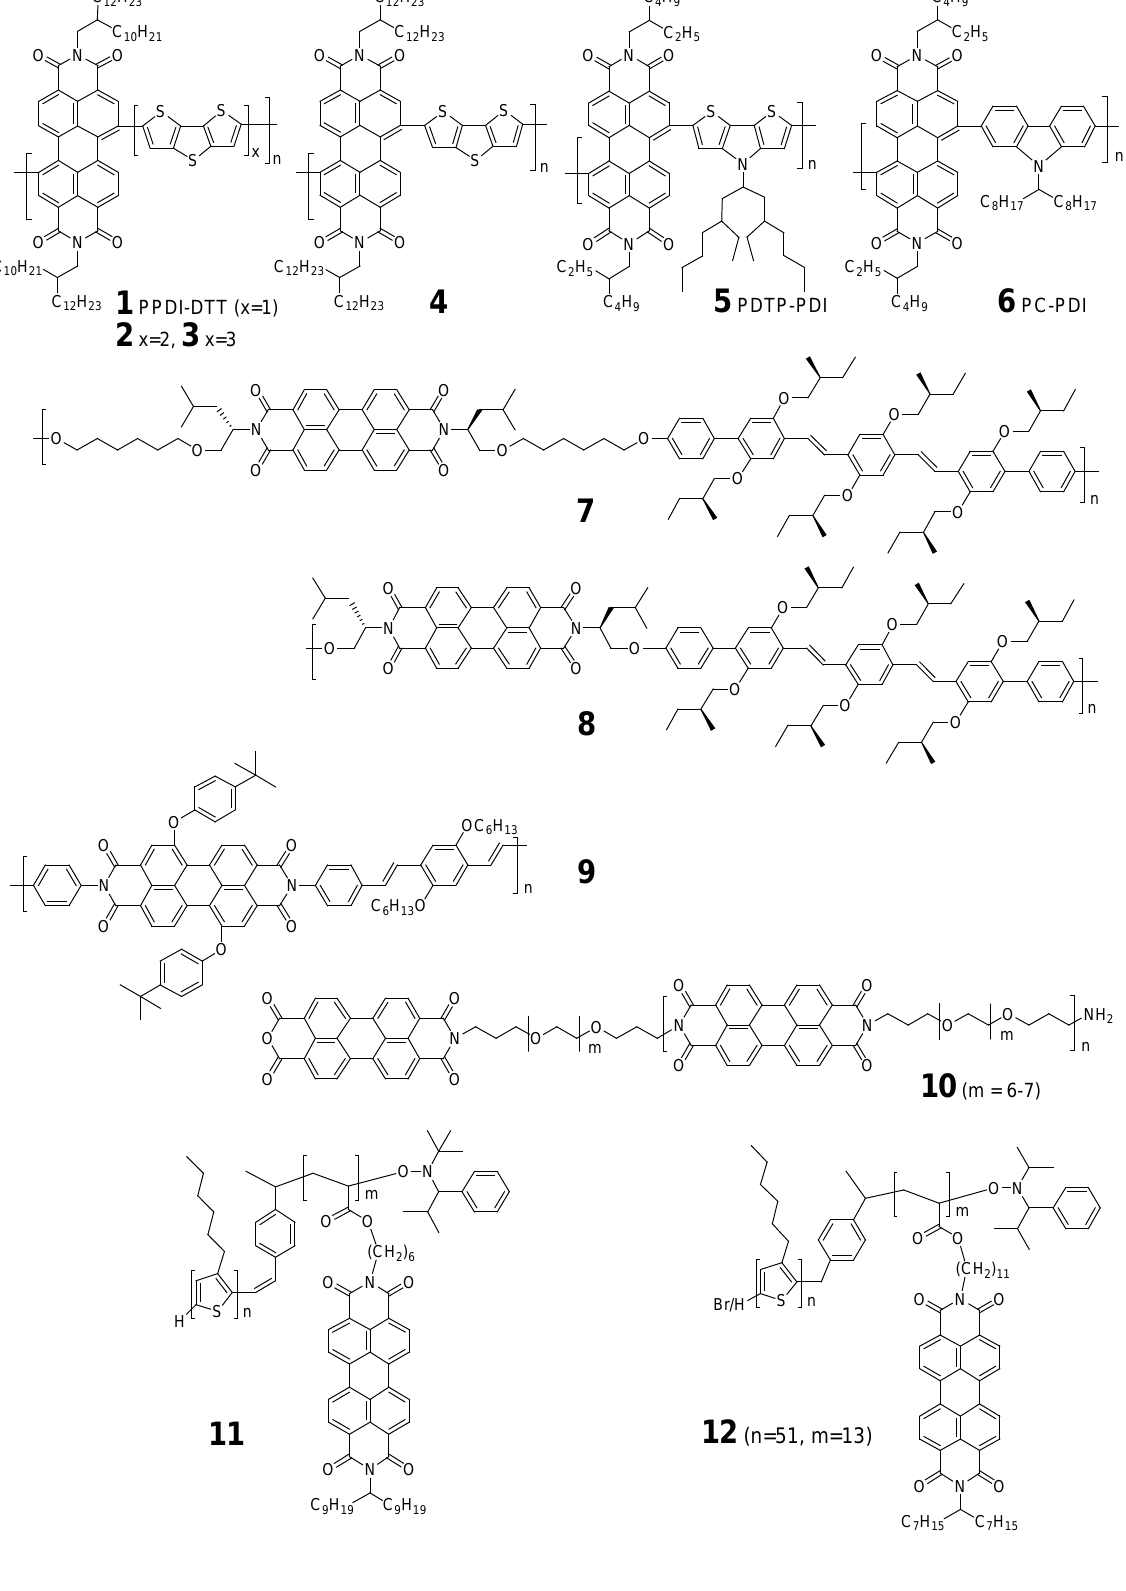
Figure 2. Molecular structures of perylene diimide (PDI)-based polymer acceptors ( 1 – 12